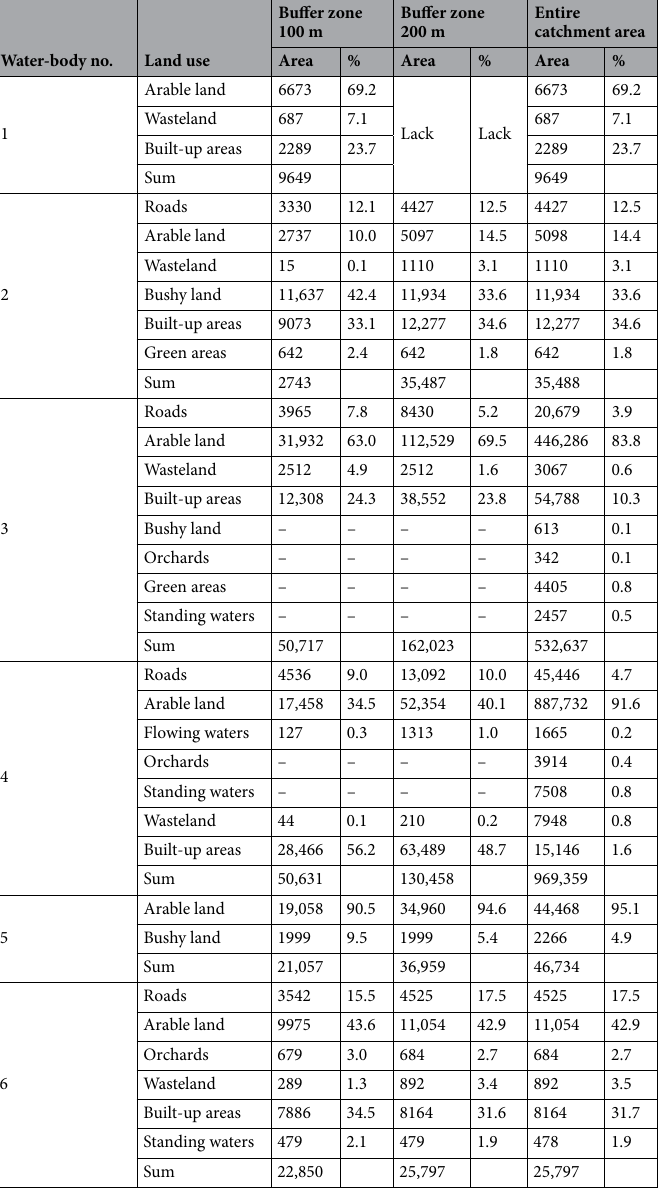
Table 2. Land use in the buffer zones and in the entire catchment